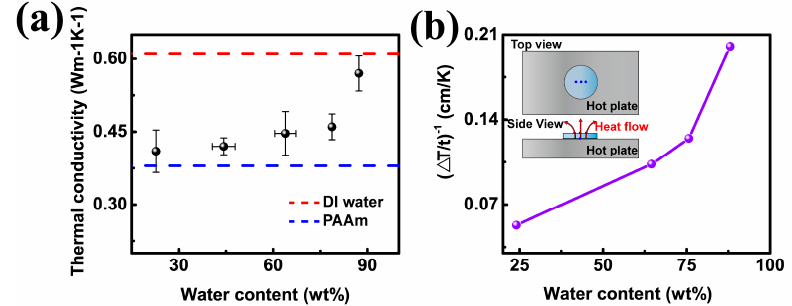
Figure 3. Demonstration of the thermal conductivity of the PAAm hydrogel with 0.099 mol % crosslinker and different water content. ( a ) 3 ω based measurement for thermal conductivity of PAAm hydrogels with varied water content; ( b ) Heat dissipation ability with change of water content. Inset: Illustration of measurement of heat dissipation for PAAm hydrogels. The blue dots represent thermocouples. Three thermocouples are put on the surface of sample with distance of about 2 mm between each other, and another one is under the bottom of hydrogel. Temperature gradient come from the difference between the value of the bottom thermocouple and the average value of the three top thermocouples in the equilibrium state.